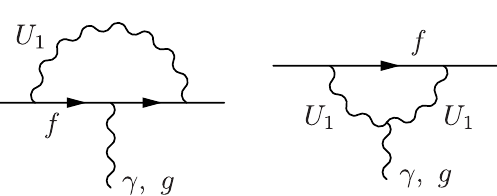
Figure 1 . Feynman diagrams contributing to the dipole moments of quarks and leptons from leptoquark